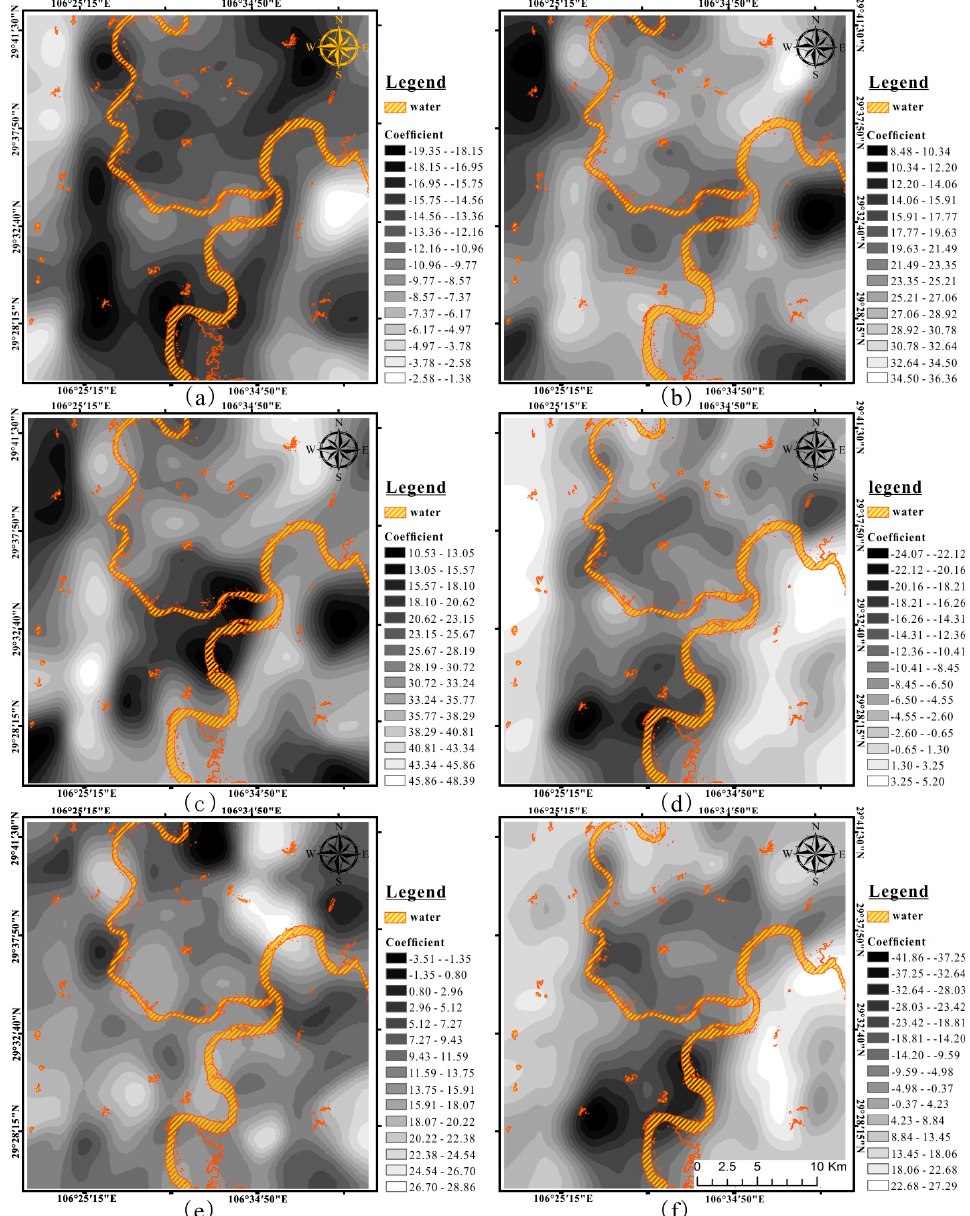
Figure 3. The spatial distribution of the local coefficients estimated by GWR models at a spatial resolution of 30 m. ( a – c ) are the slope coefficients for the SAVI, IBI, and NDSI in single-factor models, respectively; and ( d – f ) are the coefficients for the SAVI, IBI, and NDSI in multi-factor models, respectively. Moreover, the yellow area represents water.